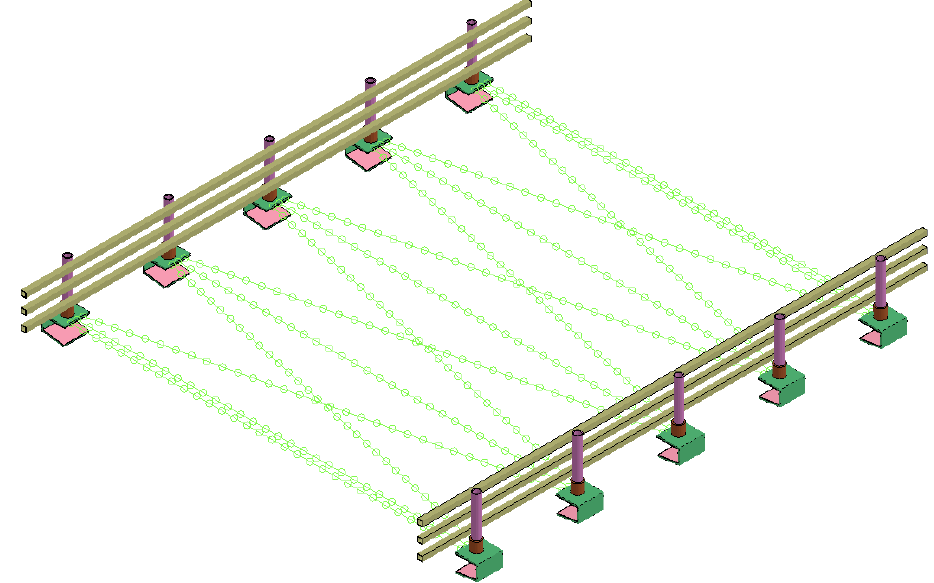
Figure 3. Three-dimensional drawing of the preassembled bridge